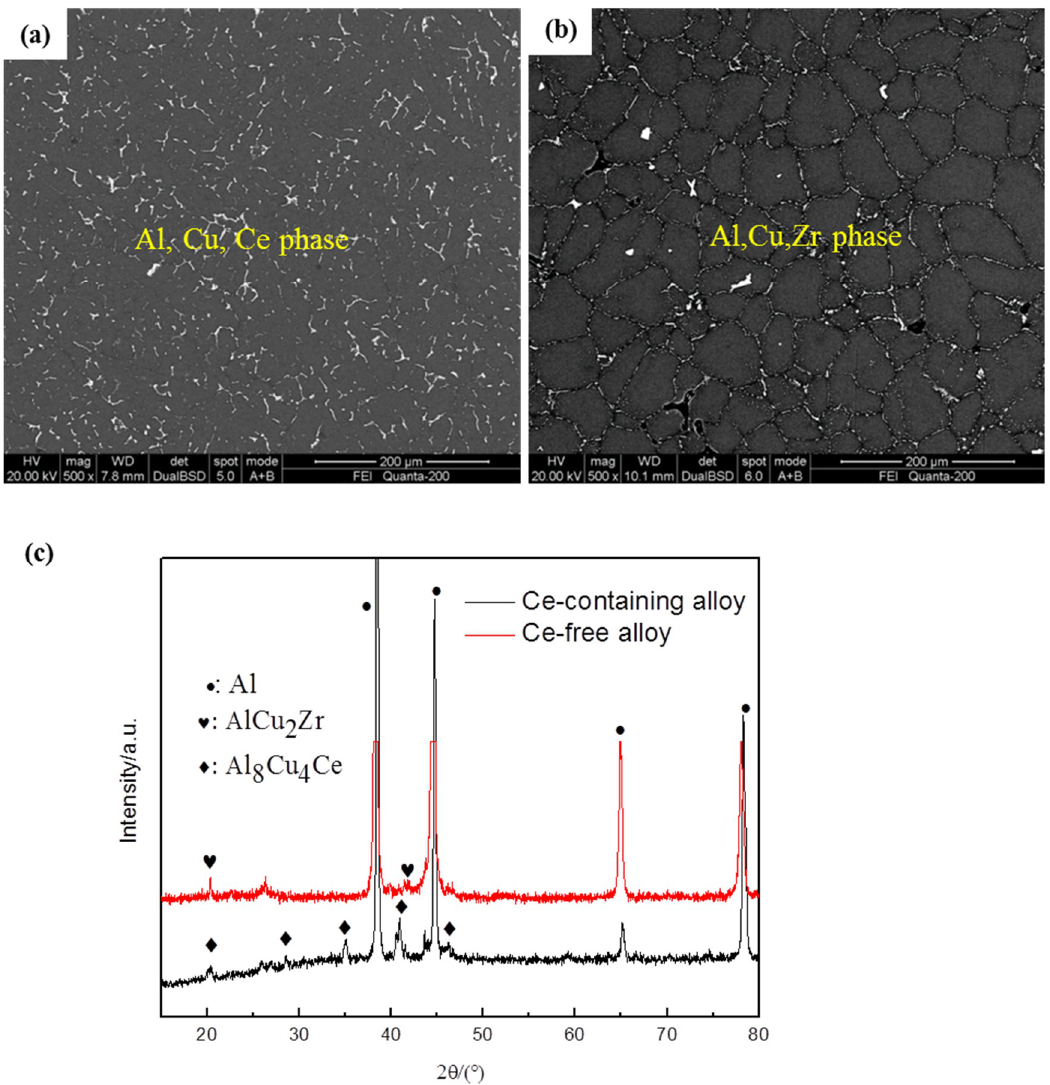
Figure 5. SEM and XRD patterns of the as-homogenized experimental alloys ( a ) Ce-containing alloy; ( b ) Ce-free alloy; ( c ) XRD patterns.